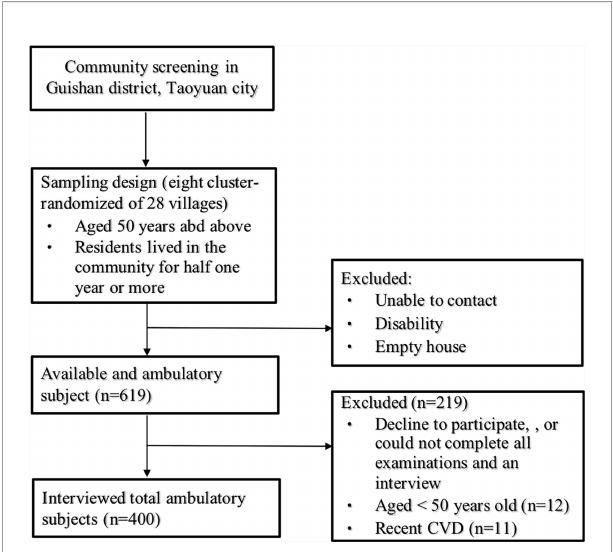
FIGURE 1 | Flow chart of study